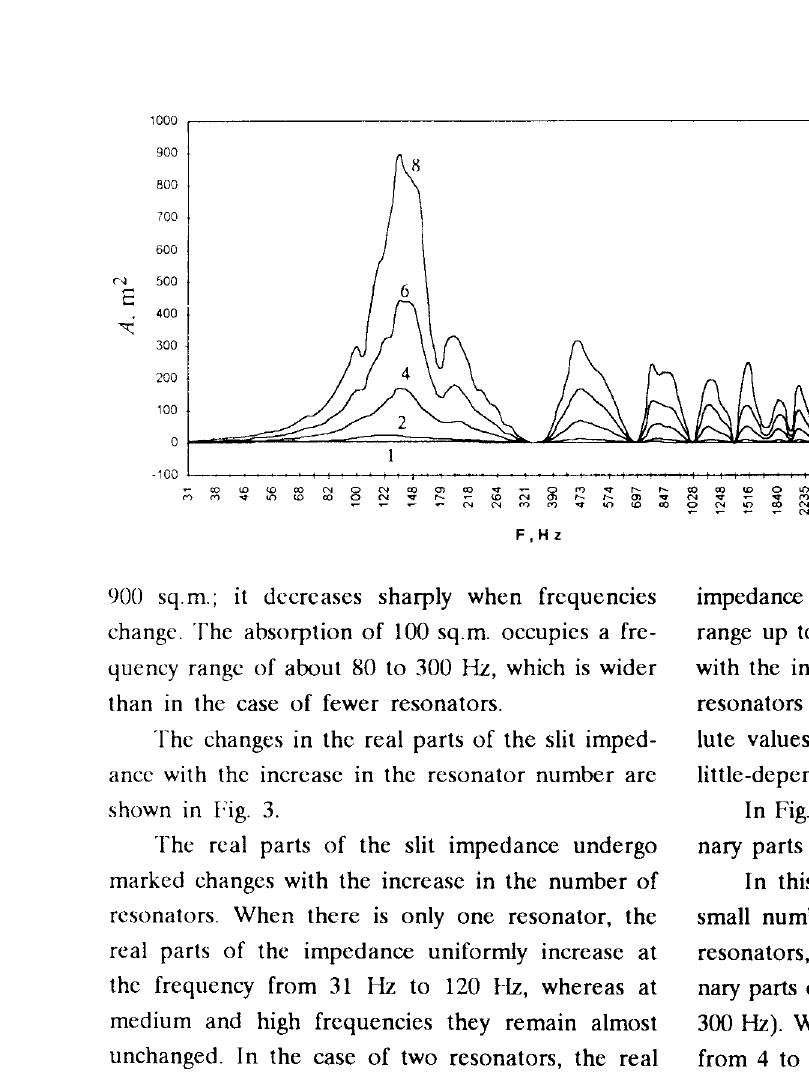
Fig. 2. The dependence of the sound absorption area of the resonators with cross-shaped slits on the number of resonators. Slit width is 50 em and slit height is 50 em. I, 2, 4, 6 and 8 - I, 2, 4, 6 and 8 resonators rcspectivelly